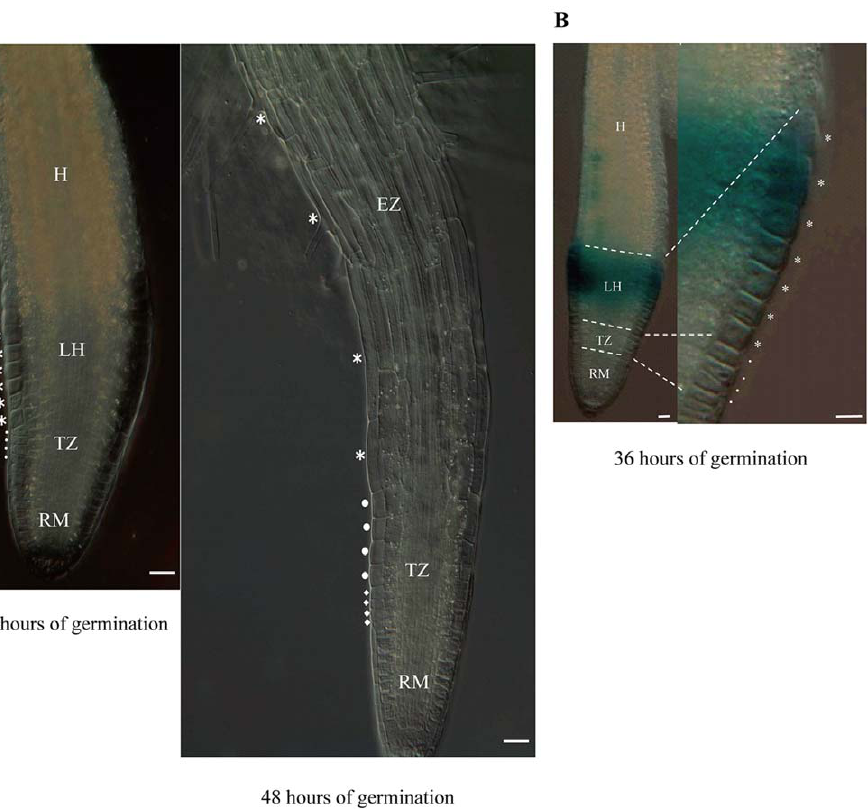
Figure 6. Elongation growth of the cells in lower hypocotyl and transition zone, and the occurrence of strong HRS1 expression in lower hypocotyl cells, during Arabidopsis seed germination. Lower hypocotyl (LH) cells are marked by asterisks, whereas the cells in transition zone (TZ) are labeled by filled dots. (A) Comparison of LH and TZ cells in the radicle samples collected at 24 or 48 HOG. Both LH and TZ cells were elongated from 24 to 48 HOG, with the magnitude of the elongation being substantially larger for LH cells. At 48 HOG (immediately post germination), an elongation zone (EZ), differentiated mainly from elongated LH cells, was found in the young seedling root. In addition, four newly developed TZ cells (indicated by diamonds) were observed on top of the root meristematic region. (B) The occurrence of strong HRS1 expression in the LH cells (of the promoter::GUS reporter line RL3-11) as indicated by the blue signals produced by histochemical staining of GUS activity at 36 HOG. The expression pattern shown was typical of four separate staining experiments, and was found for all three independent promoter::GUS reporter lines of HRS1 . EZ, elongation zone; H, hypocotyl; LH, lower hypocotyl; RM, root meristem; TZ, transition zone. Bars=50 m m.